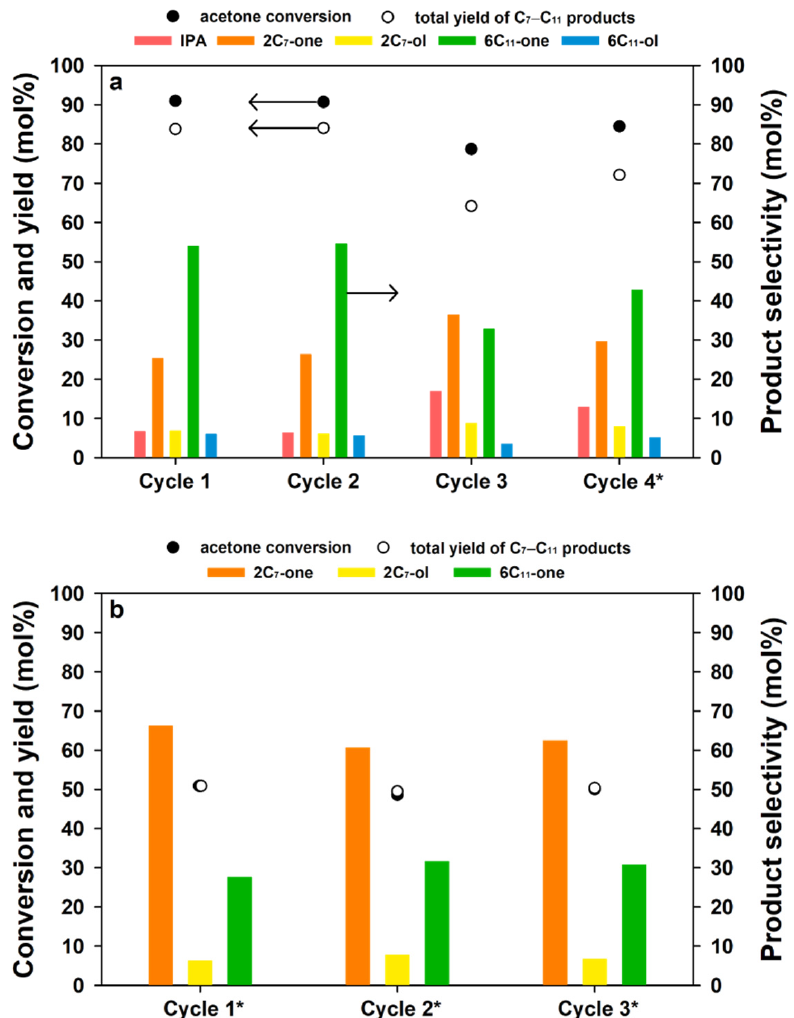
Figure 10. Catalytic performance of 5 wt % Cu/Pr 2 Zr 2 O 7 in the cross-coupling of acetone with butanol in recycle runs. Reaction conditions: 20 g reactant with the butanol/acetone mole ratio of 2, catalyst 1 g, ( a ) 240 ◦ C and ( b ) 200 ◦ C, and 20 h. * For cycle 4 in panel ( a ) and for all the cycles in panel ( b ), the catalyst was obtained by calcination at 400 ◦ C and H 2 reduction at 250 ◦ C, which is different from the other cycles using only H 2 reduction at 250 ◦ C for 2 h.